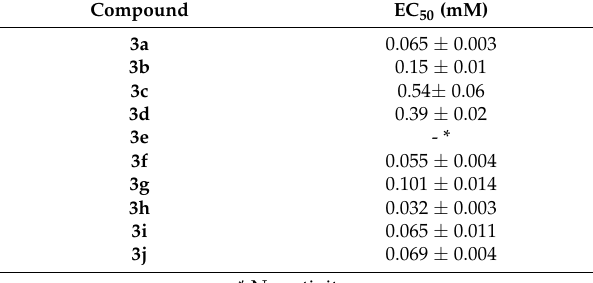
Table 3. Effect of compounds 3a–j on the mycelial growth of B. cinerea in solid medium.